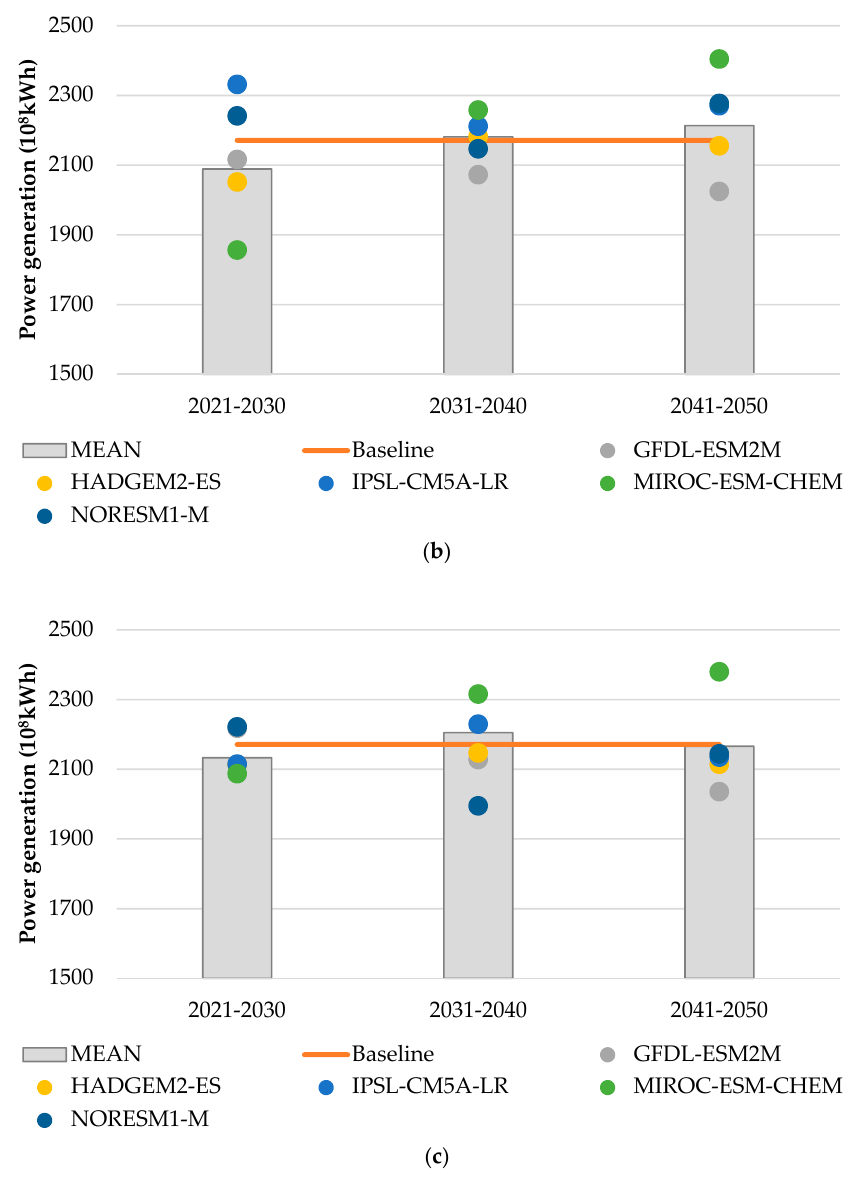
Figure 11. Power generation in the next three decades under scenario ( a ) RCP2.6; ( b ) RCP4.5; and ( c ) RCP8.5.